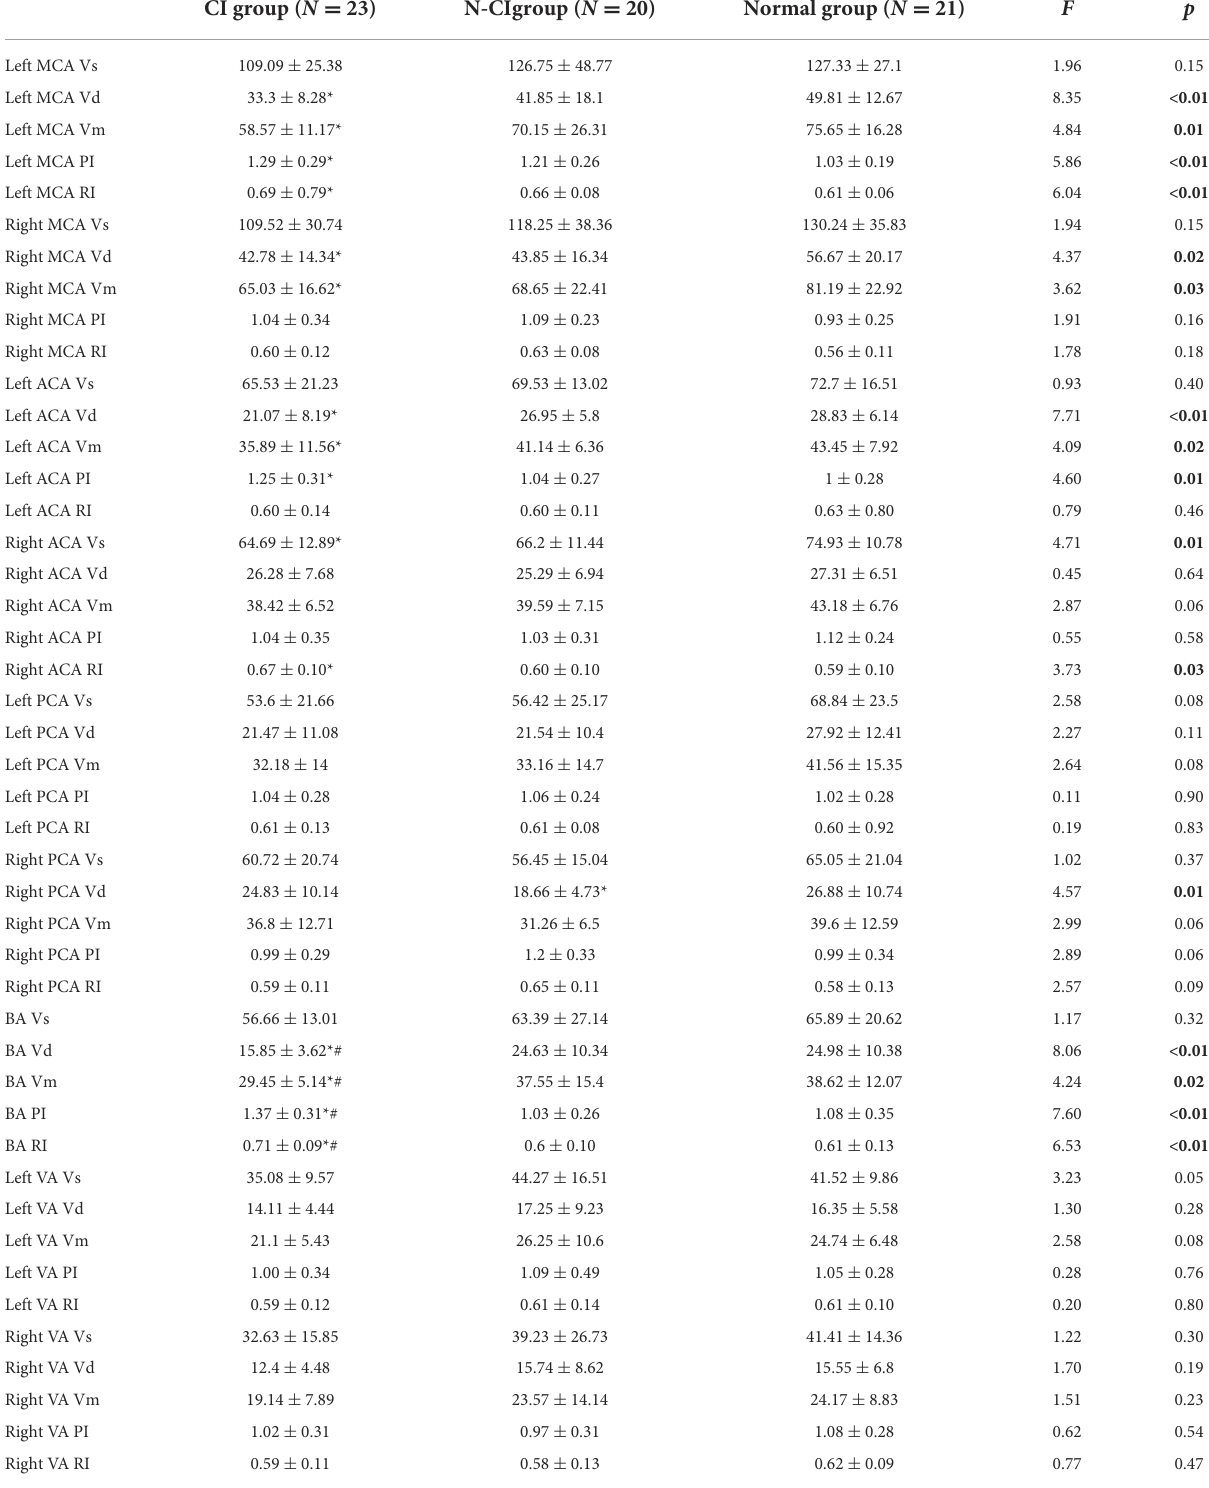
TABLE 3 TCD parameters of the study